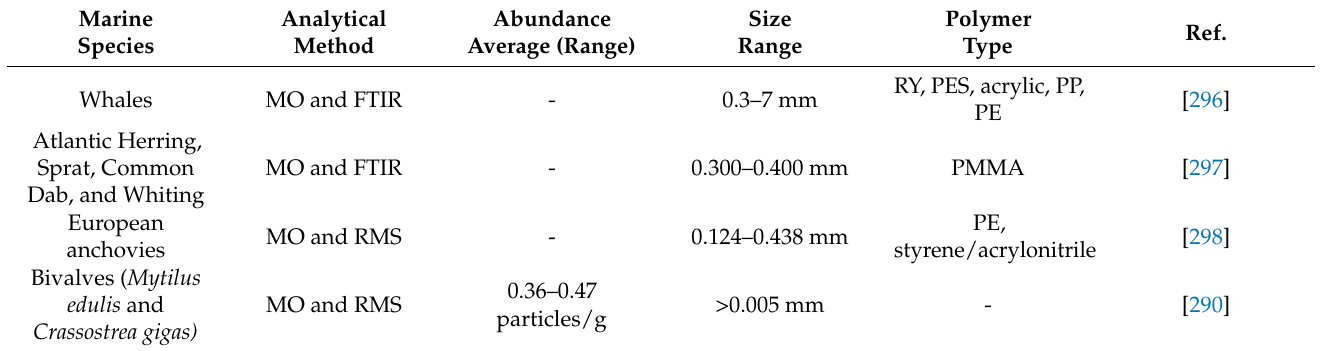
Table 4. Occurrence and quantification of microplastics in marine